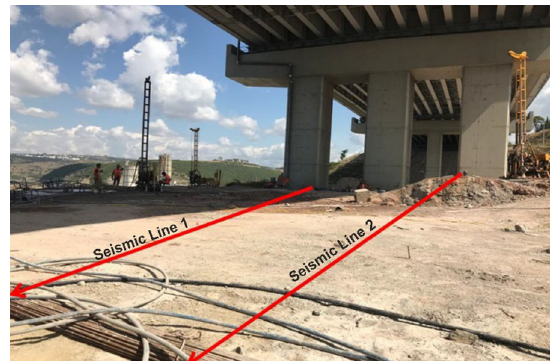
Fig. 12 Distribution of the MASW measurement point over the